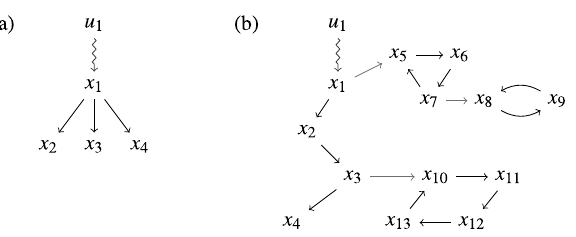
Figure 1. ( a ) Characteristic expansion of a dilation and ( b ) an example of a cactus. The red edges (namely from x x x x x x 5 , 3 to 10 , and 7 to 8 ) are the distinguished edges of their respective 1 to